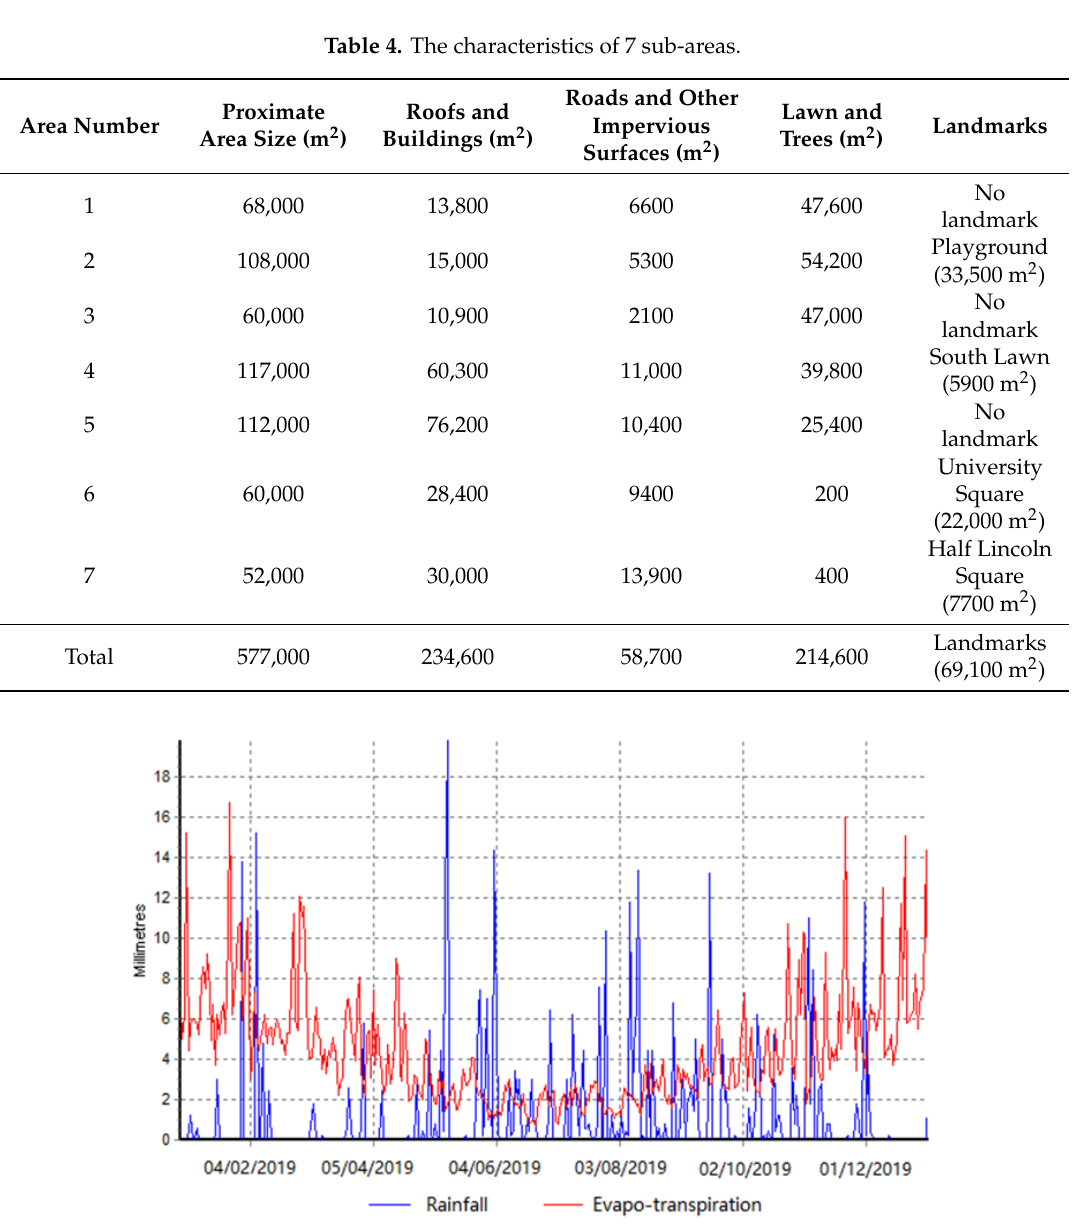
Table 4. The characteristics of 7 sub-areas.